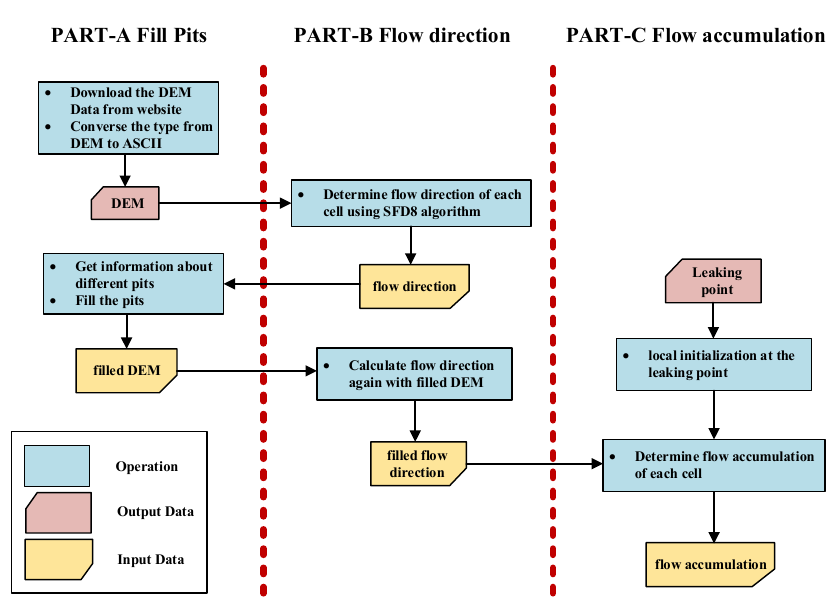
Figure 9. Workflow of the oil-leaking simulation based on the SFD algorithm.